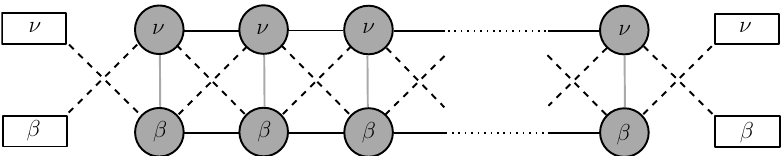
Figure 5 . The quiver encoding our (cid:12)rst example of quantum (cid:12)eld theory. The conventions for the (cid:12)elds running along the di(cid:11)erent lines are the same as those in section